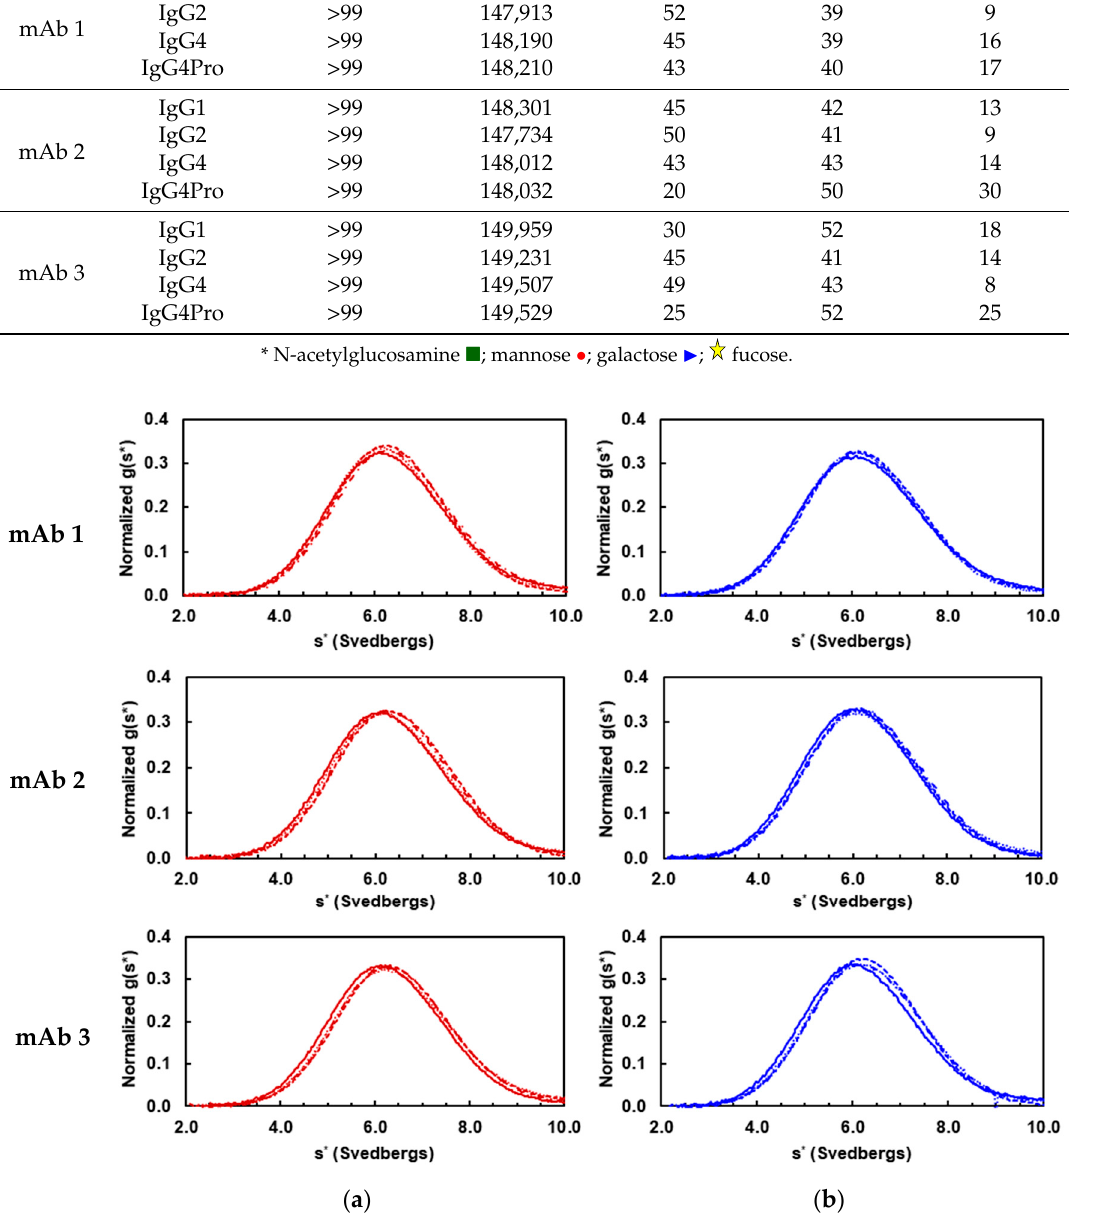
Figure 1. Sedimentation velocity analysis of IgG subclasses from mAb1, mAb2, and mAb3 in ( a ) pH 5.0 acetate (red) and ( b ) pH 7.4 PBS (blue) solutions. Normalized g(s*) sedimentation distributions are obtained from IgG1 (solid line), IgG2 (dotted line), IgG4 (dashed line), and IgG4Pro (dot-dashed line) in both buffers. The curves are superimposed on each other in both panels.